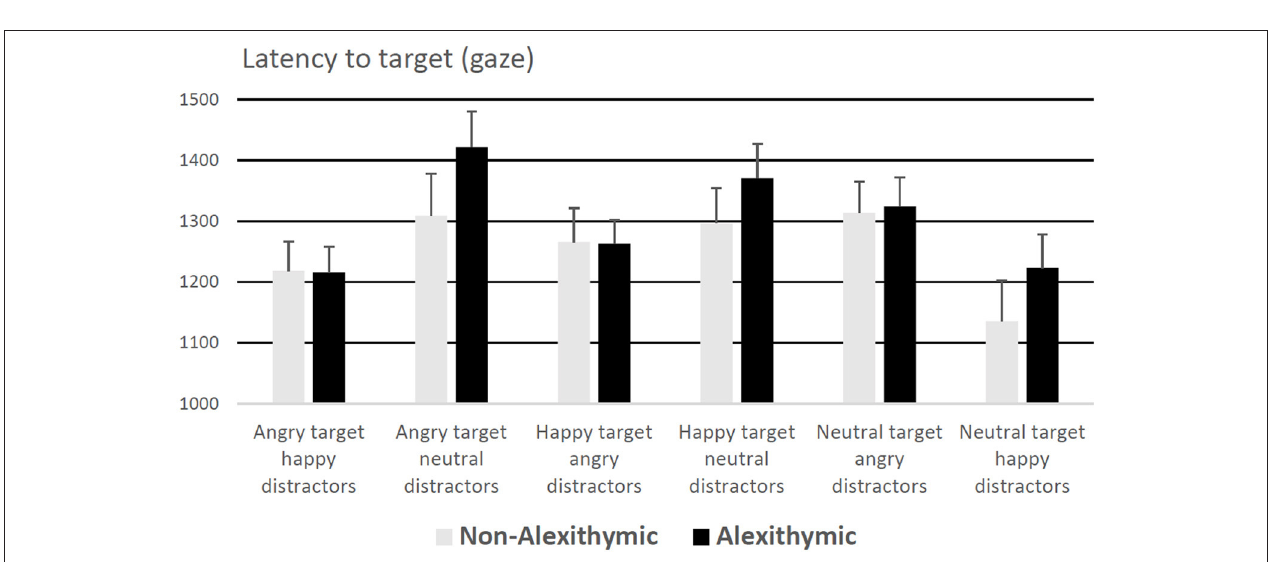
FIGURE 2 | Latency to target (for correct responses) in ms as a function of alexithymia and emotional quality of target and distractor face. Error bars represent standard error.